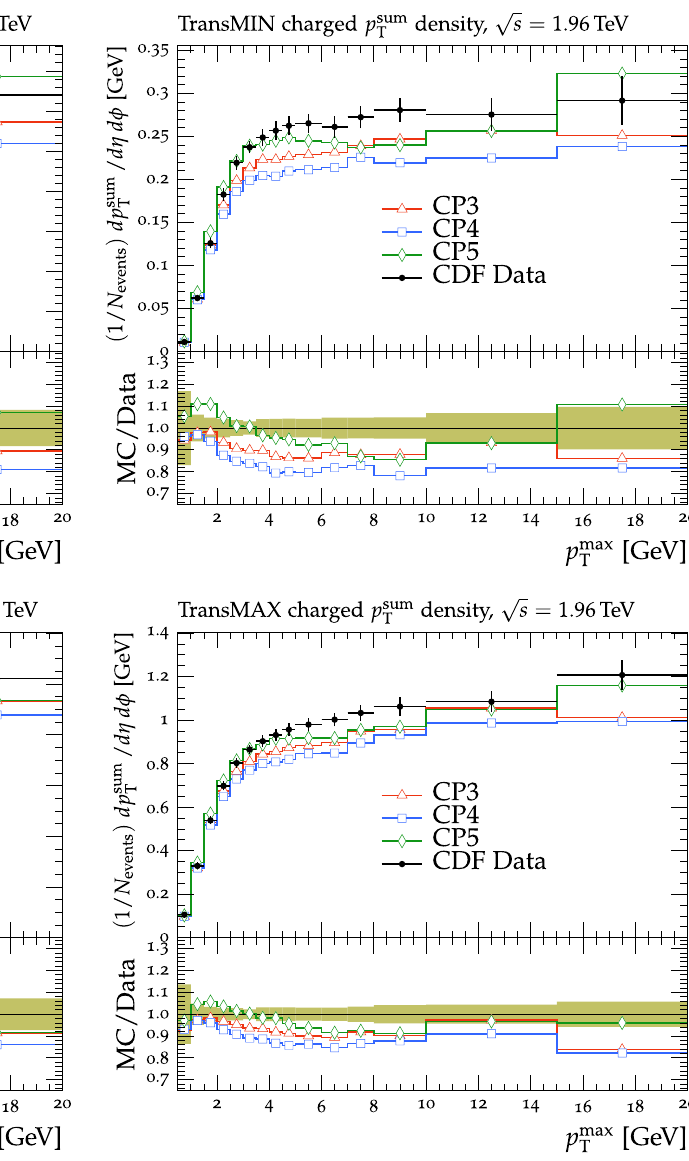
pythia 8 (N)NLO-PDF tunes CP3, CP4, and CP5. The ratios of simu- Fig. 9 The transMIN (upper left) charged-particle and charged p sum T lations to the data (MC/Data) are also shown, where the shaded band (upper right) densities and the transMAX (lower left) charged-particle indicates the total experimental uncertainty in the data. Vertical lines and charged p sum (lower right) densities, as a function of the trans- T drawn on the data points refer to the total uncertainty in the data. Ver- verse momentum of the leading charged particle, p max , from the CDF √ T s = 1 . 96TeV analysis [9]. Charged hadrons are measured with tical lines drawn on the MC points refer to the statistical uncertainty in p T > 0 . 5GeV in | η | < 0 . 8. The data are compared with the CMS the predictions. Horizontal bars indicate the associated bin